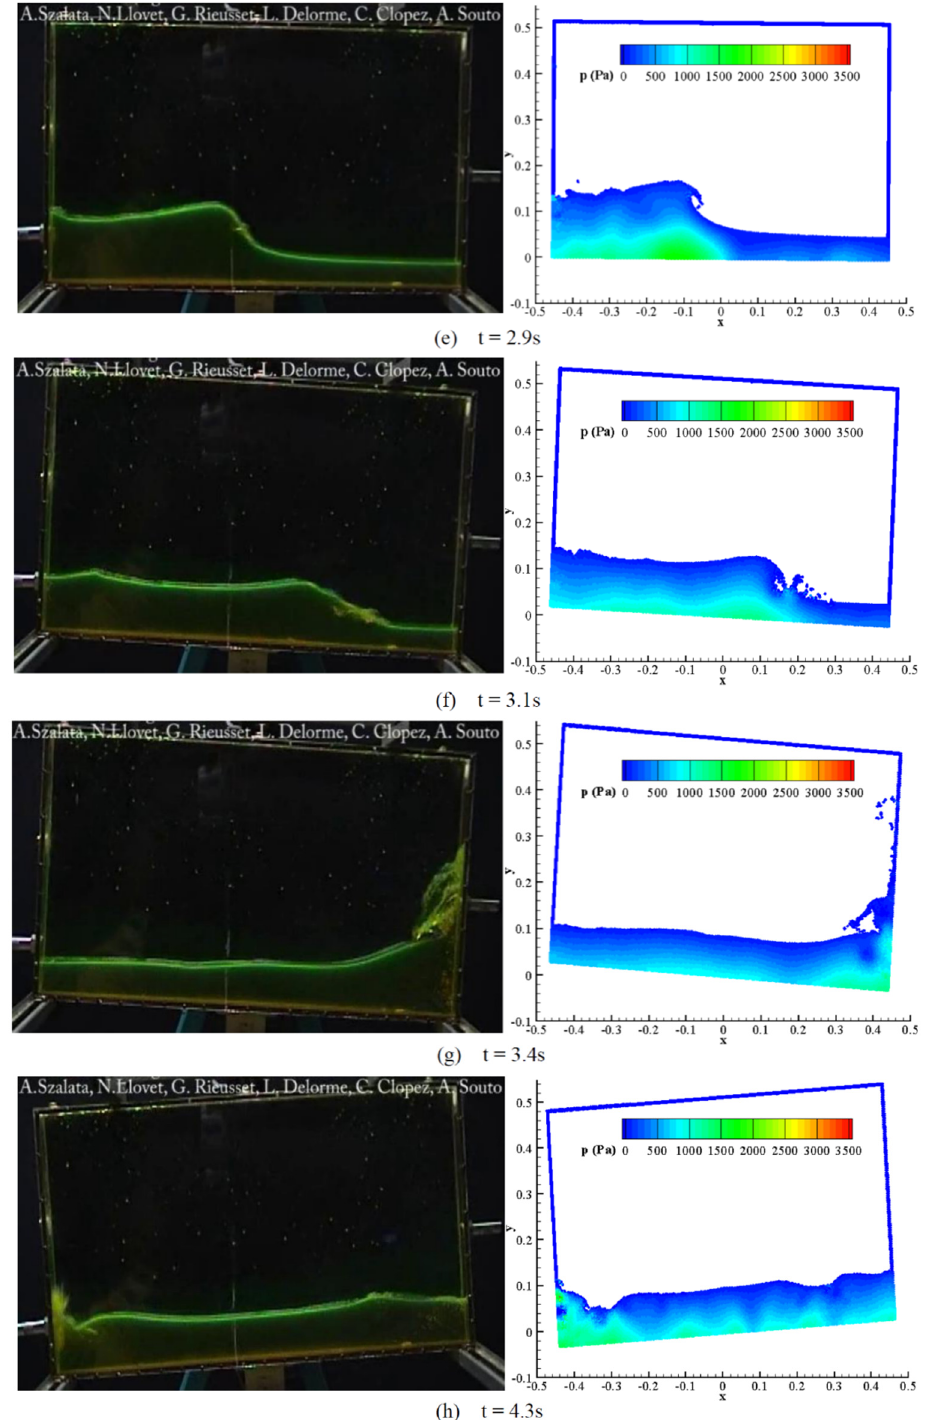
Figure 3. Comparisons of SPH–computed snapshots of water–free surface ( right ) with experimental pictures ( left ) for case A.